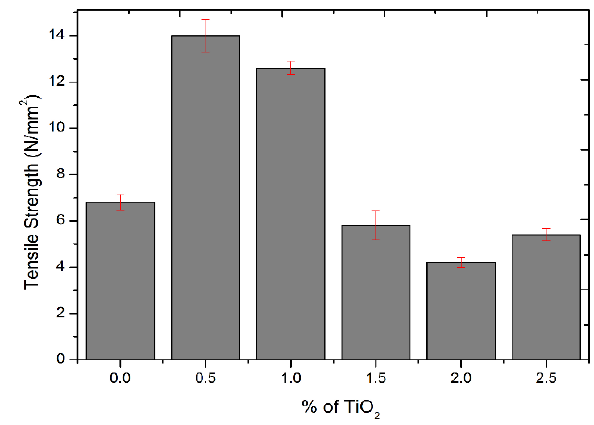
Fig. 5. Tensile strength of epoxy-TiO 2 nanocomposites at different concentrations